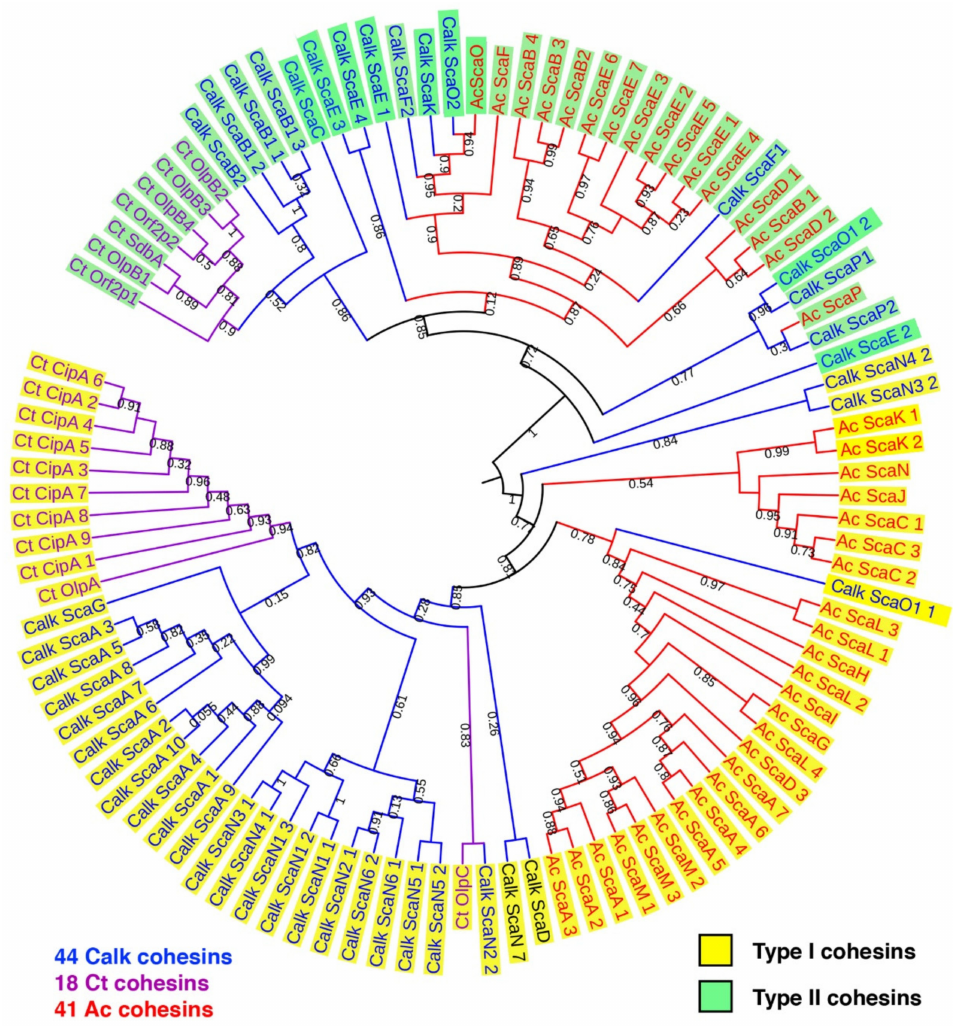
Figure 2. Phylogenetic relationship of C. alkalicellulosi cohesins with other characterized cohesins from C. thermocellum and A. cellulolyticus . The tree was constructed based on 44, 18, and 41 cohesin modules of C. alkalicellulosi (Calk, blue), C. thermocellum (Ct, purple), and A. cellulolyticus (Ac, red), respectively. Numbers on the branches represent bootstrap